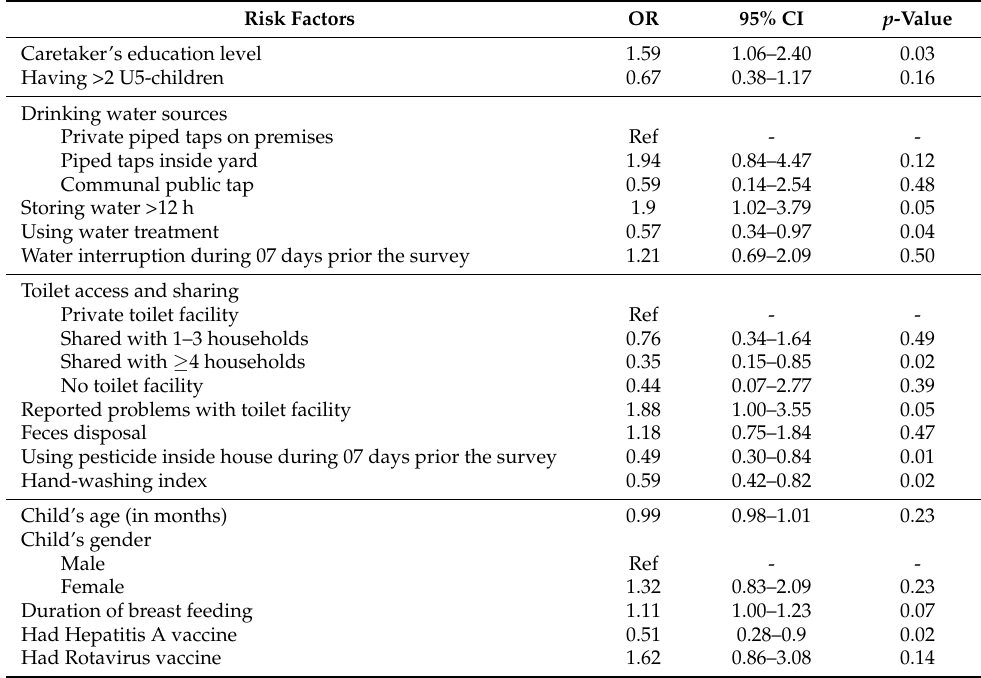
Table 4. The multi-level multivariate mixed-effects logistic regression analysis of risk factors associ- ated with